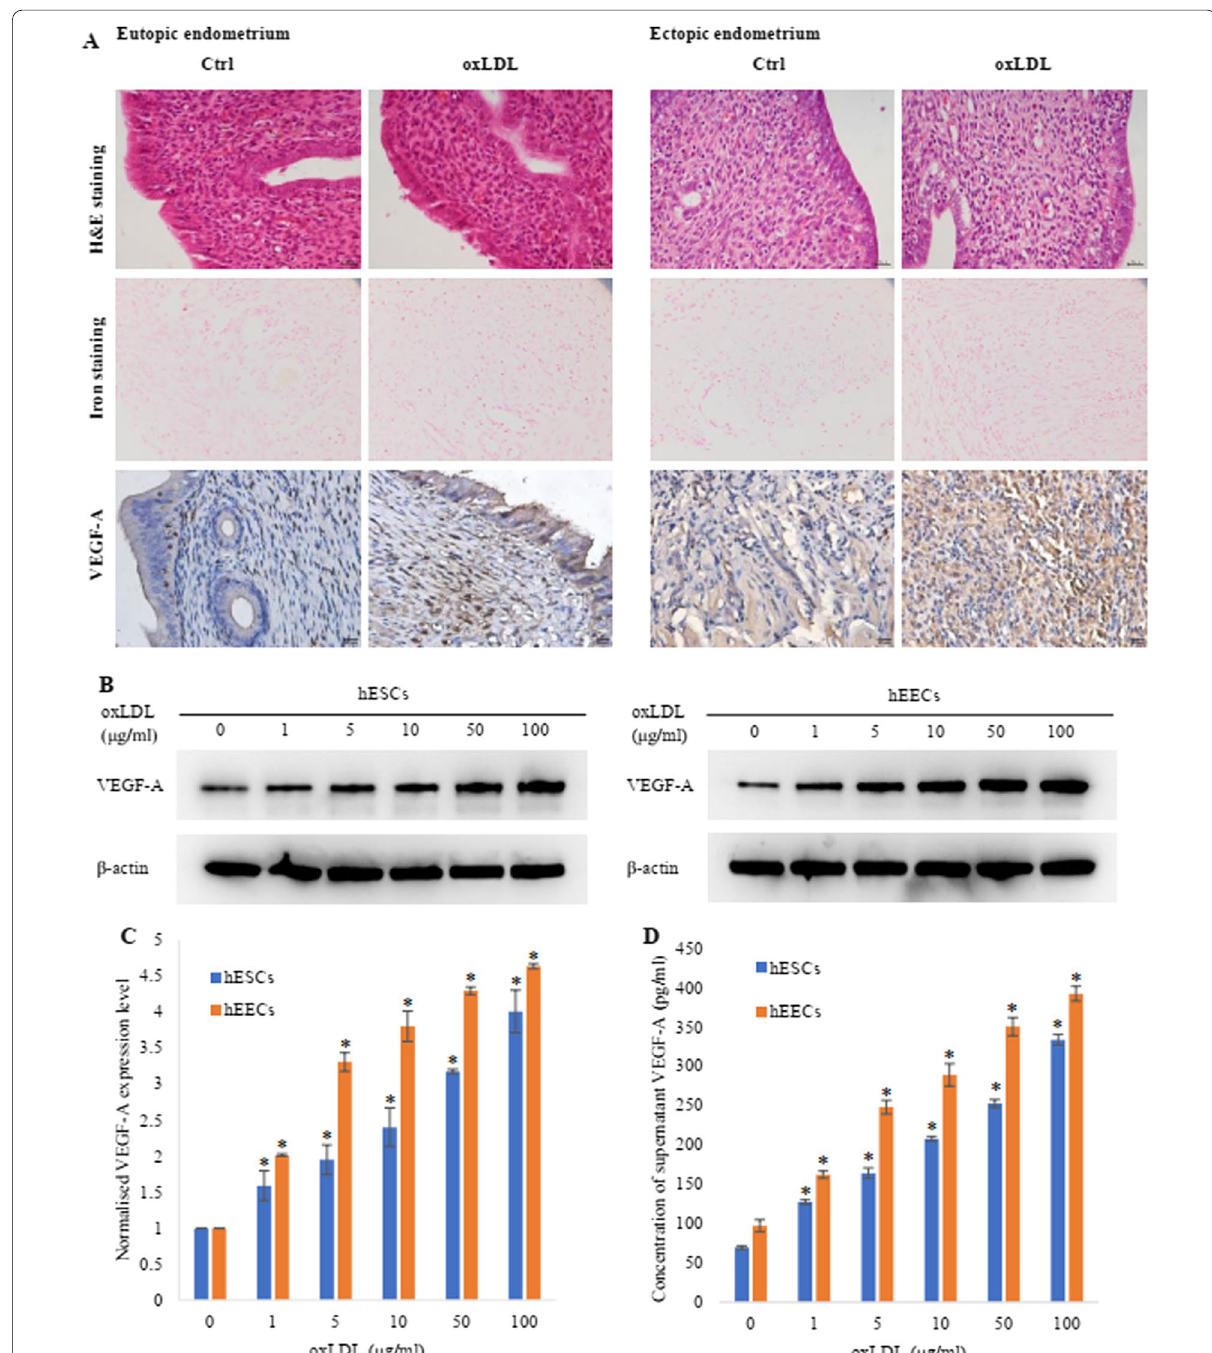
Fig. 4 OxLDL increased the expression and secretion of VEGF-A in endometrial cells. A VEGF-A expression in eutopic endometrium and ectopic endometrium from the animal models treated with oxLDL (dissolved in PBS solution) or the same volume of PBS for 48 h. VEGF-A was stained by immunohistochemistry, while all the tissues were also stained by H&E and iron. B , C Western blot analysis of VEGF-A expression in the hESCs and hEECs treated with oxLDL and PBS. The histogram represents the greyscale of each lane from the Western blot. The number in each group was 3. * compared with the 0 µg/ml oxLDL group, p < 0.05. D The VEGF-A secretion of the hESCs and hEECs treated with oxLDL and PBS for 48 h was tested by ELISAs. The number in each group was 3. * compared with the 0 µg/ml oxLDL group, p <